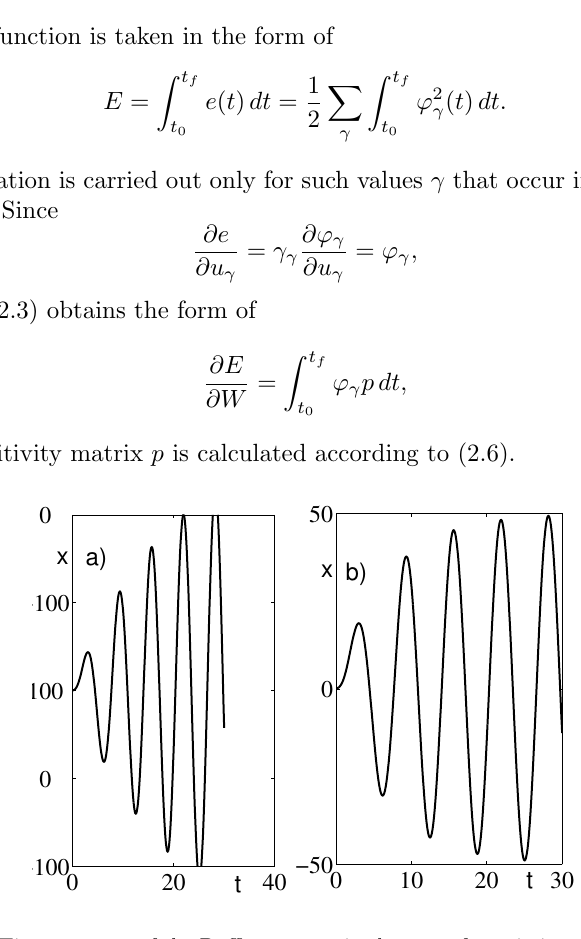
Figure 9. Time response of the Duffing system in the case of restrictions (5.4); (a) before learning, (b) after